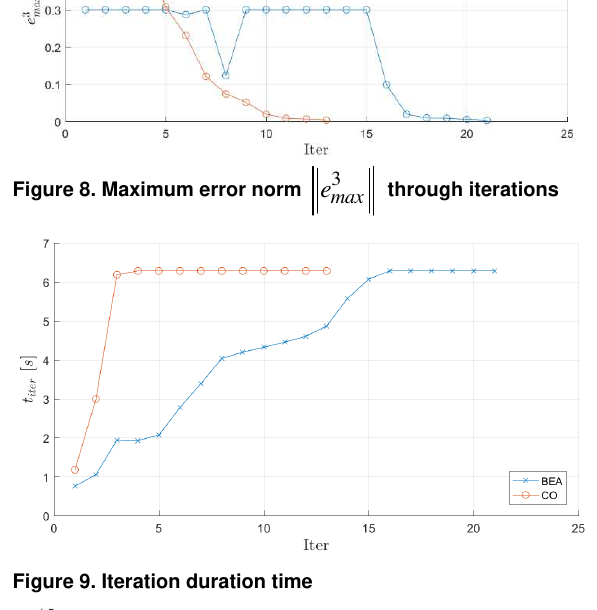
3 e through iterations max